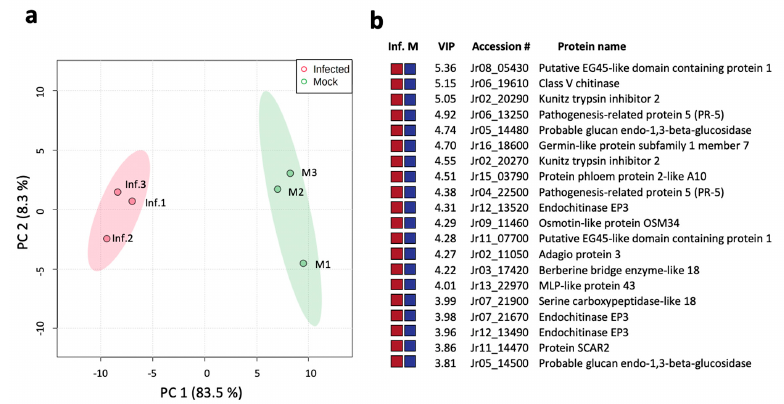
Figure 3. Juglans regia proteome analysis comparing the infected and mock-inoculated samples. ( a ) Principle component analysis (PCA) plot with distinct groups and samples. ( b ) Top 20 proteins contributing to the variance between the observed partial least squares-discriminant analysis (PLS-DA) (Figure S2a) with high variable importance in projection (VIP) scores (Table S3), with colored boxes indicating the relative abundance (greater: red and reduced: blue) of the corresponding protein detected in infected (Inf.) and mock-inoculated (M) tissues. Ratio log 2 fold-change (log 2 FC) analysis of the detected proteins in infected and mock samples (Figure 4a) showed 1537 proteins with FDR ≤ 0.01 (high confidence), 322 with FDR ≤ 0.05 (medium), 187 with FDR ≤ 0.1 (low), and 1250 not significantly different (no confidence) than the mock- inoculated control. The protein abundance ranged from 3.29 to 8.68 (log 10 scale) and log 2 FC from - 3.26 to 4.95 (Figure 4a). The total number of significantly differentially abundant proteins between the two groups was 2046 (FDR ≤ 0.1), of which 1040 were increased (log 2 FC > 0) and 1006 were decreased (log 2 FC < 0) in the infected samples. An analysis of statistical significance (volcano plot) of the detected proteins showed 411 (log 2 FC ≥ 1) increased proteins (right side, Figure 4b), of which 129 were at least four times more abundant (log 2 FC ≥ 2) than in mock-inoculated nuts, considering a FDR ≤ 0.05. The total of the decreased proteins in the infected tissue was lower, with 272 log 2 FC ≤ - 1, of which only 38 decreased more than four-fold (log 2 FC ≤ -2) (left side, Figure 4b).